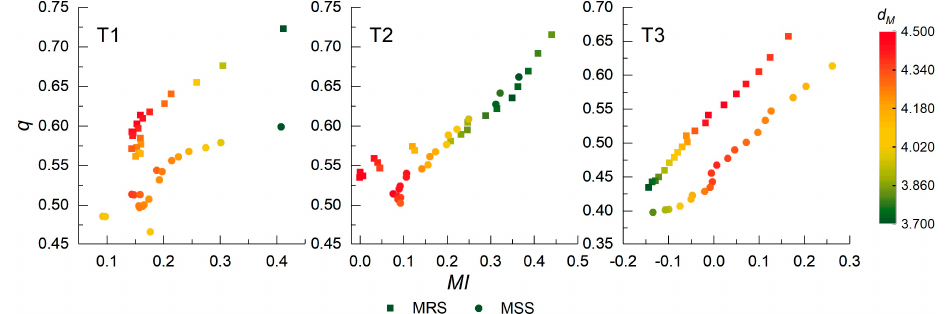
Figure 9. Quality points consisting of MI and q variables in the two-dimensional MI − q space of T1, T2, and T3. Each point corresponds to a segmentation result of MRS or MSS, and colors indicate the Mahalanobis distance to the quality point